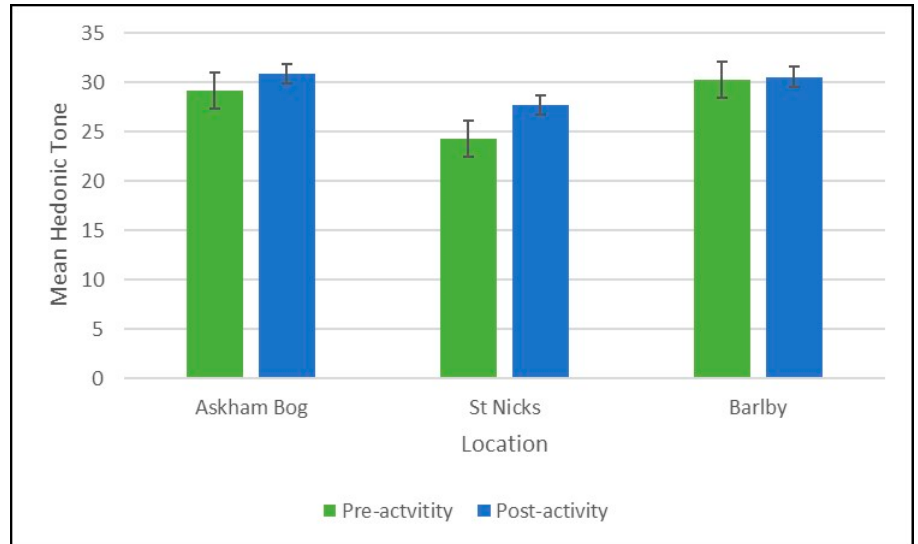
Figure 4. Mean pre- and post-hedonic tone scores by location .